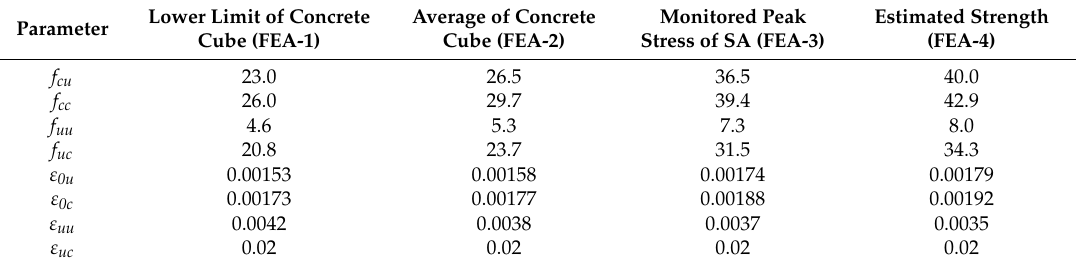
Figure 5. Concrete stress distribution and rectangular stress block. Table 1. Parameters of concrete constitutive relationship.